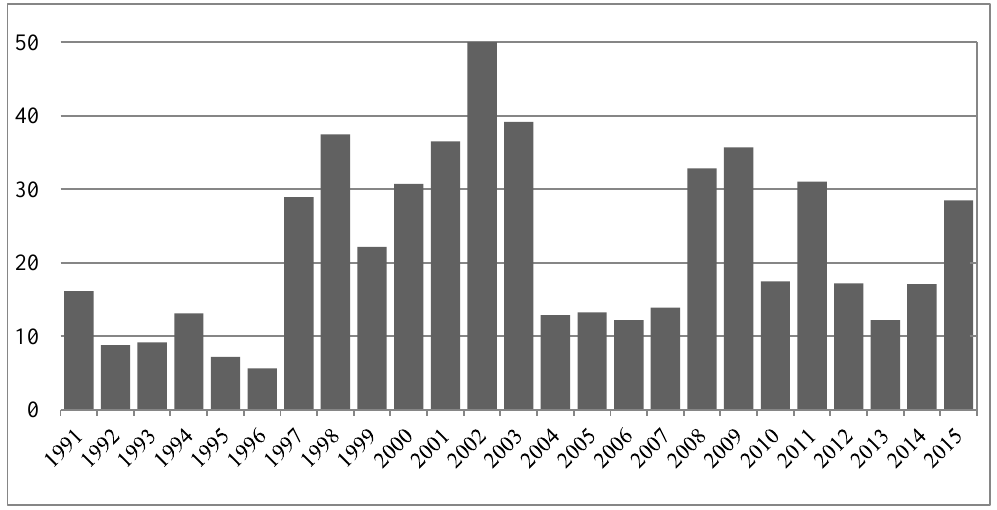
Fig. 1. The development of extreme day returns on the Frankfurt Stock Exchange from 1991 to